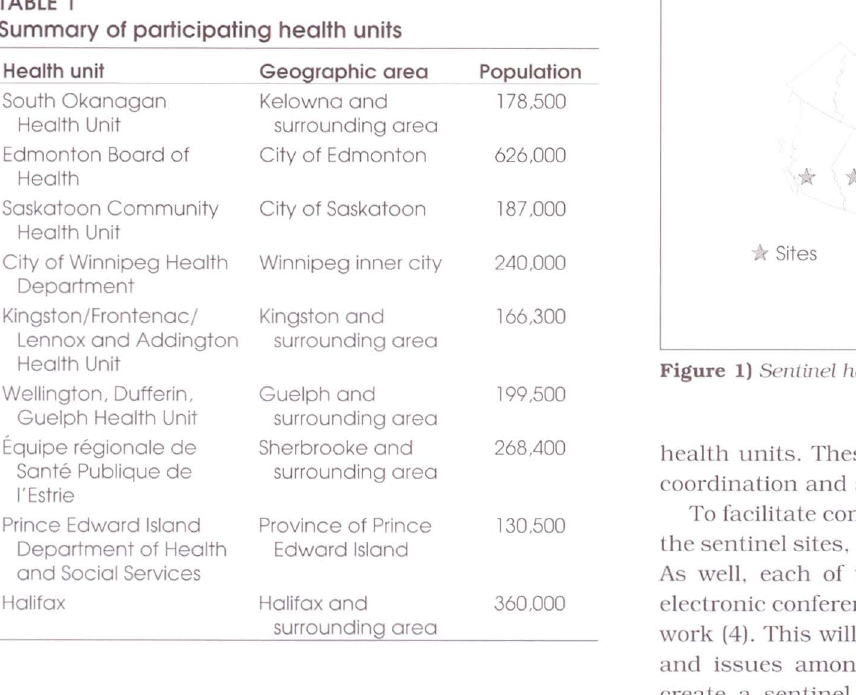
Figure 1) Sentinel health unit sites as qj'Augusl